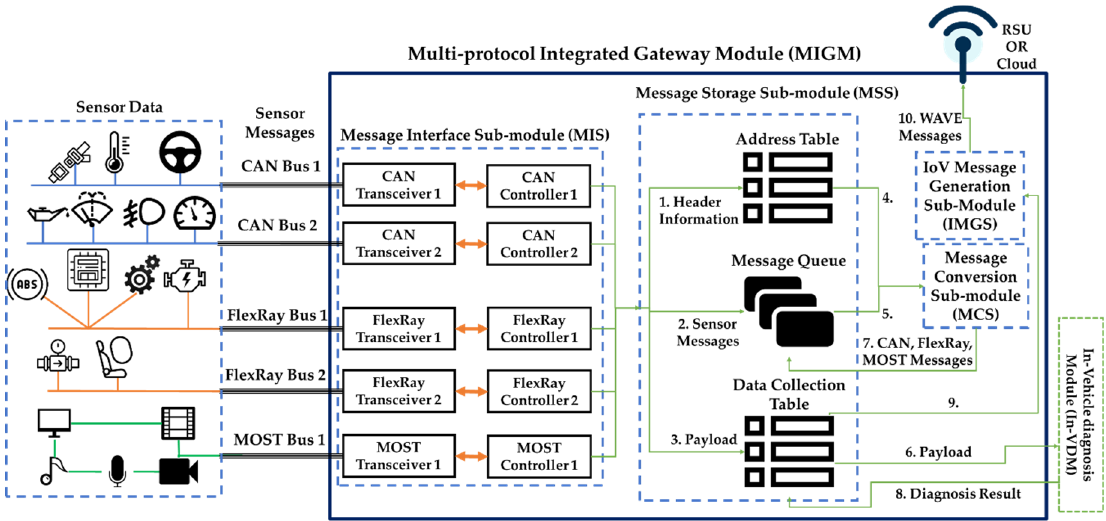
Figure 4. The structure of the multi-protocol integrated gateway module (MIGM).